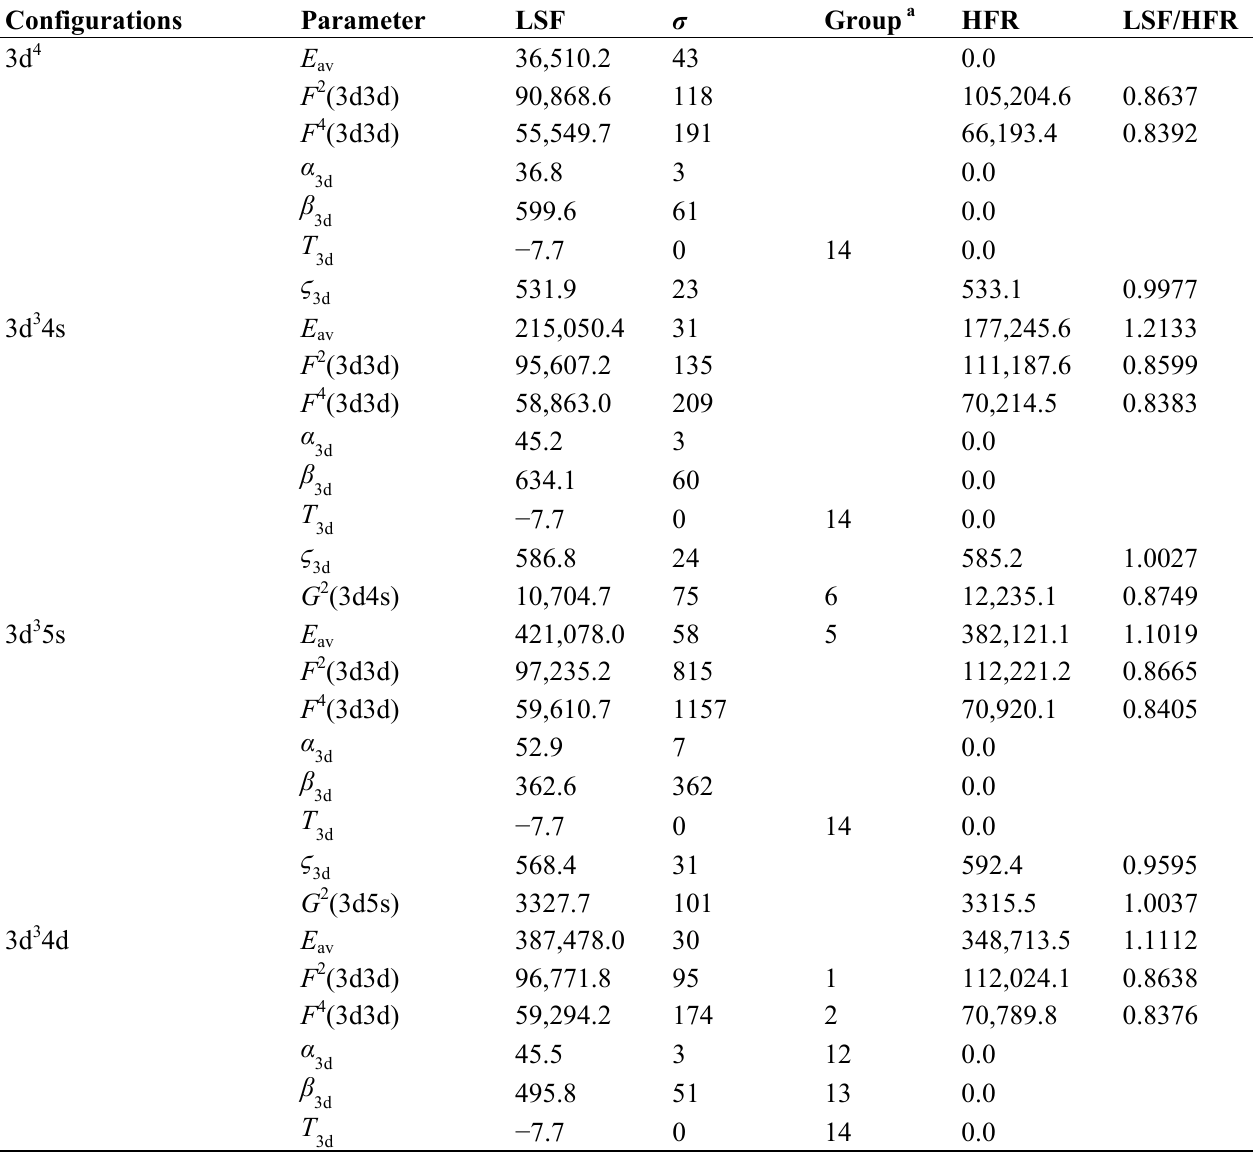
Table 1. Parameters of the least-squares fitting (LSF) used as input for Monte Carlo trials (in units of cm − 1